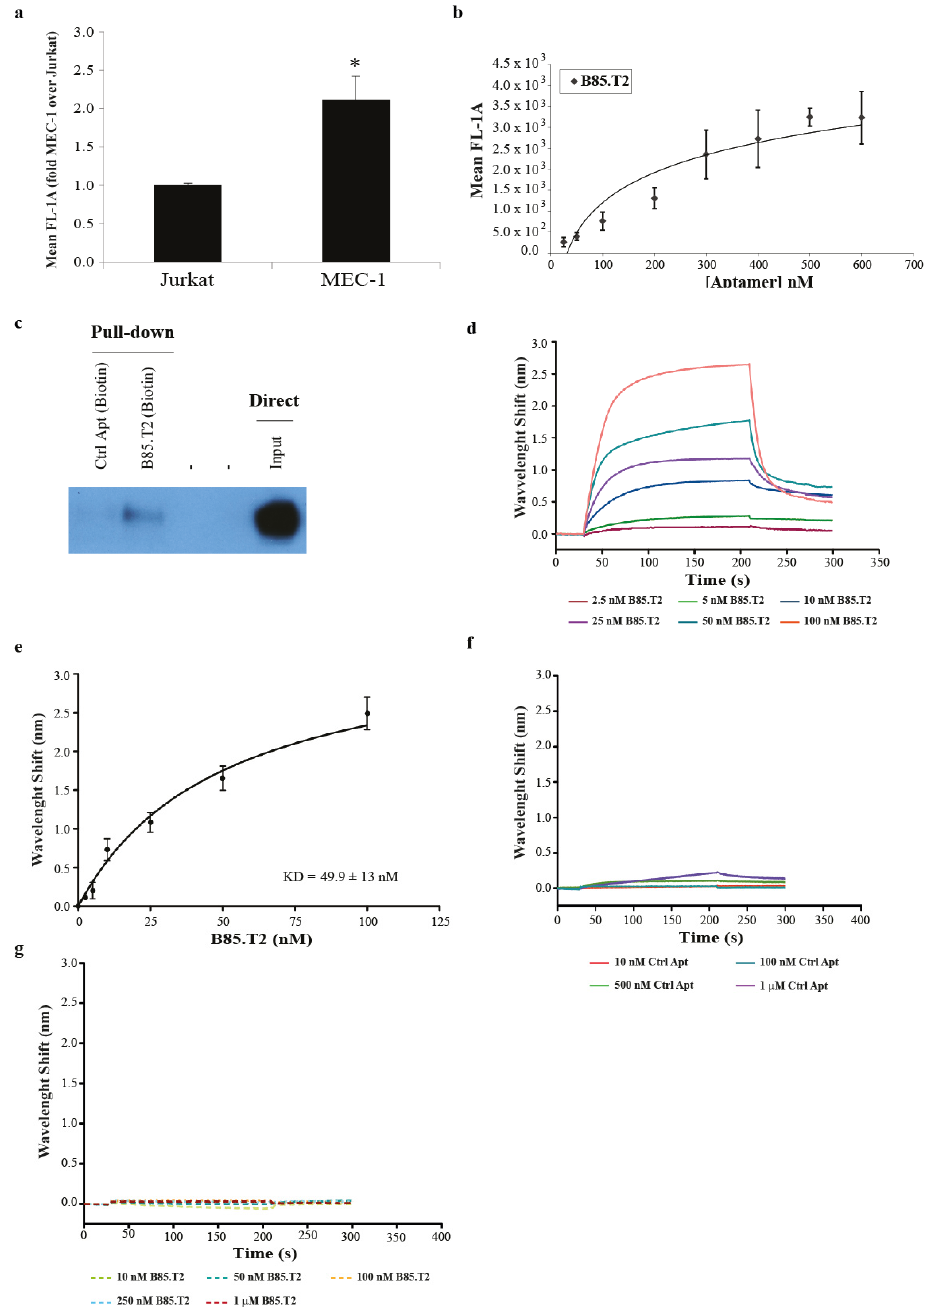
Figure 3. B85.T2 aptamer ‐ binding activity. ( a ) Binding analysis of the B85.T2 aptamer on CD19 + MEC ‐ 1 cells and CD19 ‐ Jurkat leukaemia cells. Cells were pre ‐ treated for 30 min at 37 °C with slow shaking with 0.4 μ g/ μ L tRNA and 100 nM of biotinylated Ctrl Apt as unspecific competitors. Then, the B85.T2 FAM ‐ labelled aptamer (250 nM) was added to cells for 30 min at 37 °C with slow shaking in the presence of competitors. Mean fluorescence was measured by FACS, cell auto ‐ florescence was subtracted, and data were reported in the graph as fold increase of aptamer binding on MEC ‐ 1 over Jurkat. Error bars show the mean of experimental triplicates ± SD values. Statistics was calculated using Student’s t test, *p < 0.05 ( b ) Dose ‐ dependent binding of the B85.T2 aptamer on MEC ‐ 1 cells. Cells were incubated with increasing concentrations of FAM ‐ labelled aptamer for 30 min at 37 °C in serum ‐ free medium. The mean fluorescence was measured at FACS, cell auto ‐ florescence was subtracted, and data were reported in the graph. Error bars show the mean of experimental tripli ‐ cates ± SEM values. ( c ) Aptamer ‐ mediated pull ‐ down. MEC ‐ 1 cells were incubated with 400 nM of